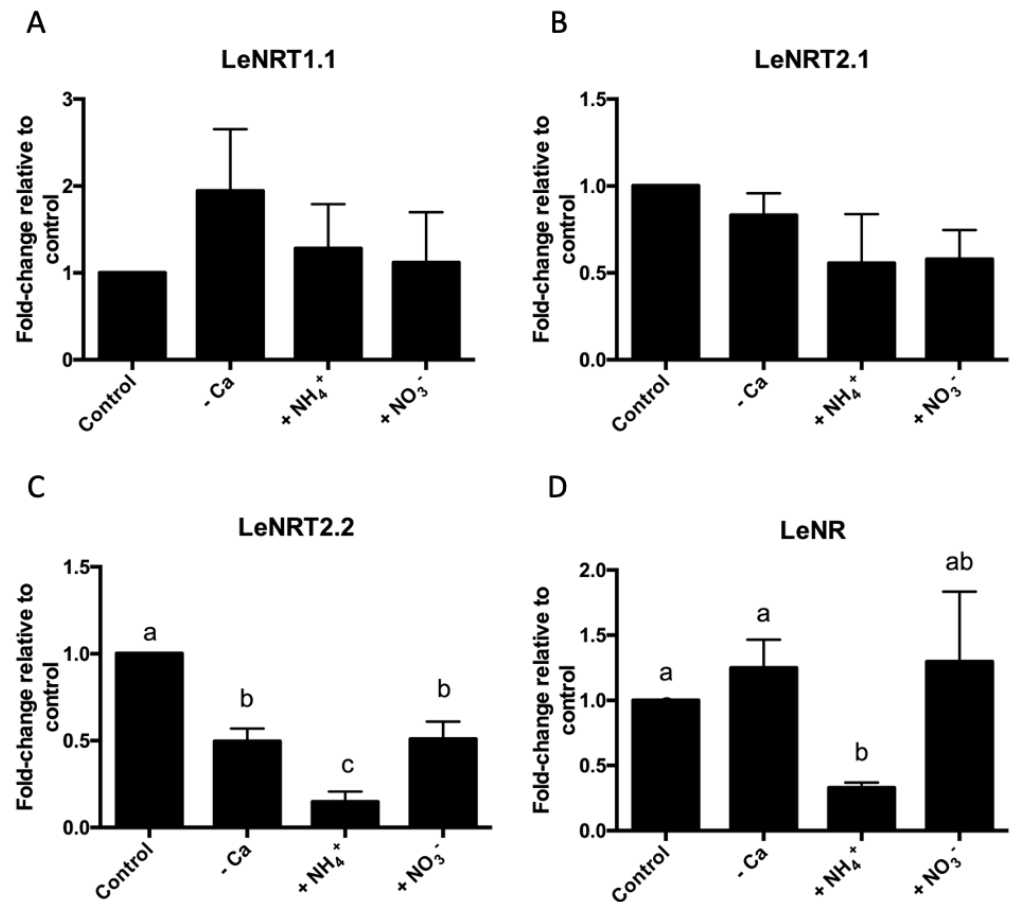
Figure 2. Nitrate transporters and nitrate assimilation gene expression levels were affected by calcium deficit or ammonium and nitrate excesses in in vitro experiment. Tomato seedlings were grown with control media, with a calcium deficit, or with ammonium or nitrate excesses for 10 days in a growth chamber as described in the Materials and Methods section. Tomato seedlings were dissected and root tissue was collected 10 days after sowing. Transcript levels were analyzed by qRT-PCR using GAPDH as the housekeeping gene: ( A ) Col-0 WT: fold-change was set for T0; ( B – D ) transcript levels from nitrate transporters LeNRT1.1 ( A ), LeNRT2.1 ( B ), LeNRT2.2 ( C ), and nitrate reductase LeNR ( D ). Fold-change was set for the control condition. Two-way ANOVA test was performed. Lowercase letters represent statistical differences with a p < 0.05. Error bars represent the SEM. Each experiment was performed at least in triplicate with at least 5–10 seedlings in each replicate. a, b, c represents statistically significant differences with p < 0.05.